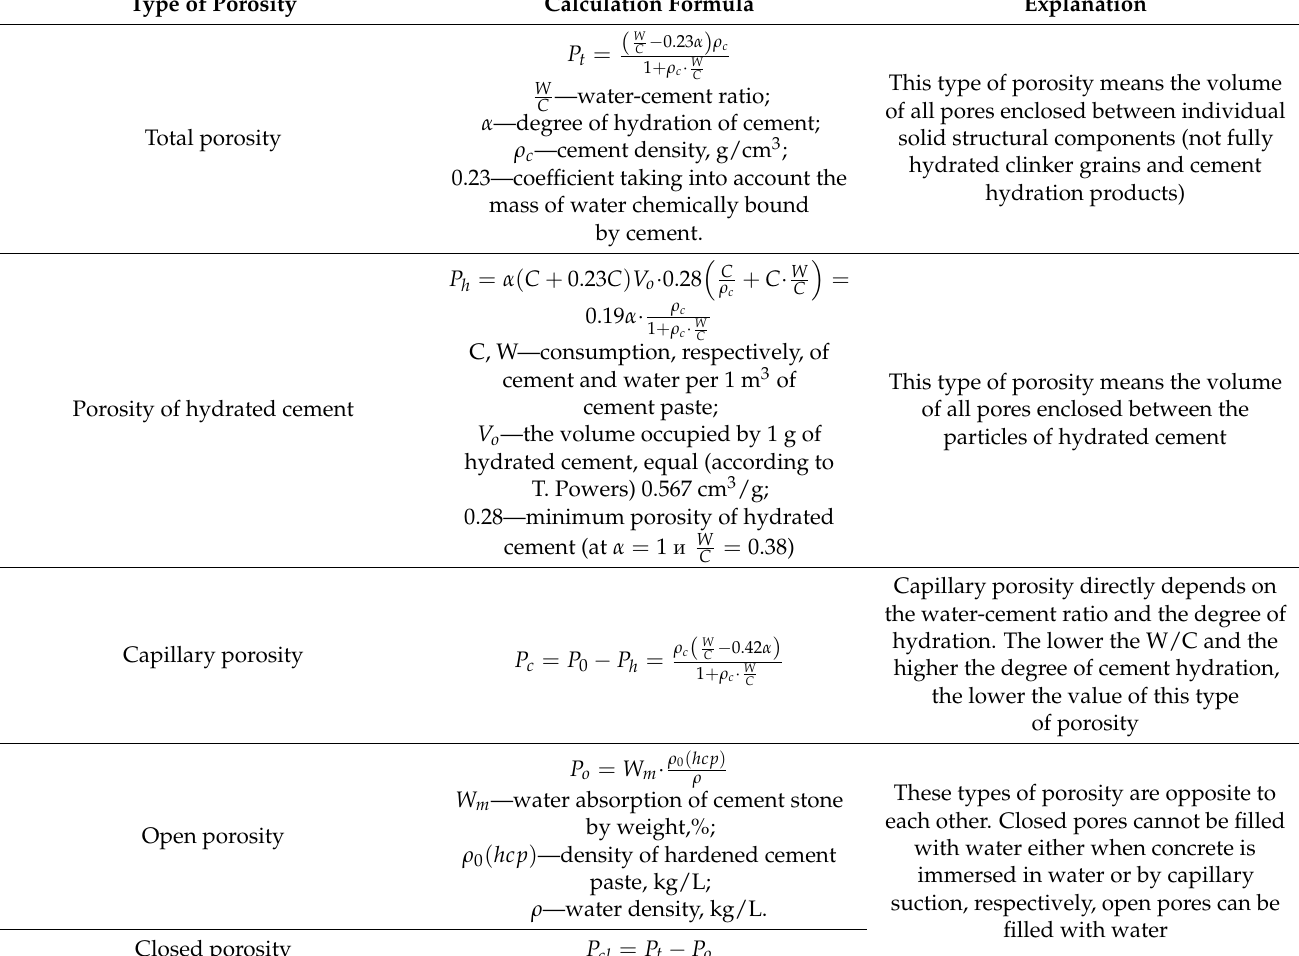
Table 2. Types of porosity of the